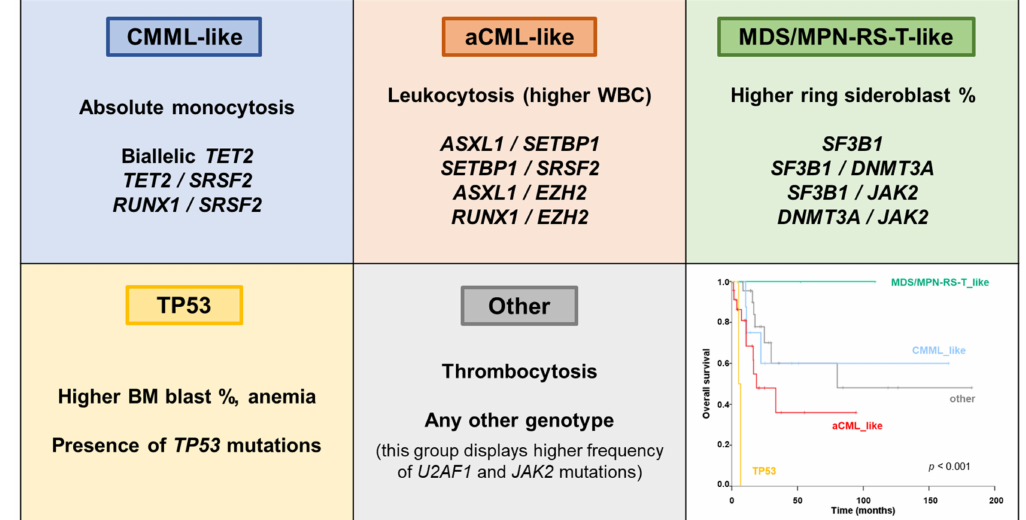
Figure 4. Molecular subtypes of MDS/MPN-U. Molecular classification of MDS/MPN-U based on the presence of specific gene mutation combinations. Morphological features of each subtype are also described in the corresponding panel. Overall survival of molecular subtypes is depicted at the bottom right corner. Based on data from Palomo et al. [4]. Abbreviations: aCML: atypical chronic myeloid leukemia; BM: bone marrow; CMML: chronic myelomonocytic leukemia; MDS/MPN-RS-T: